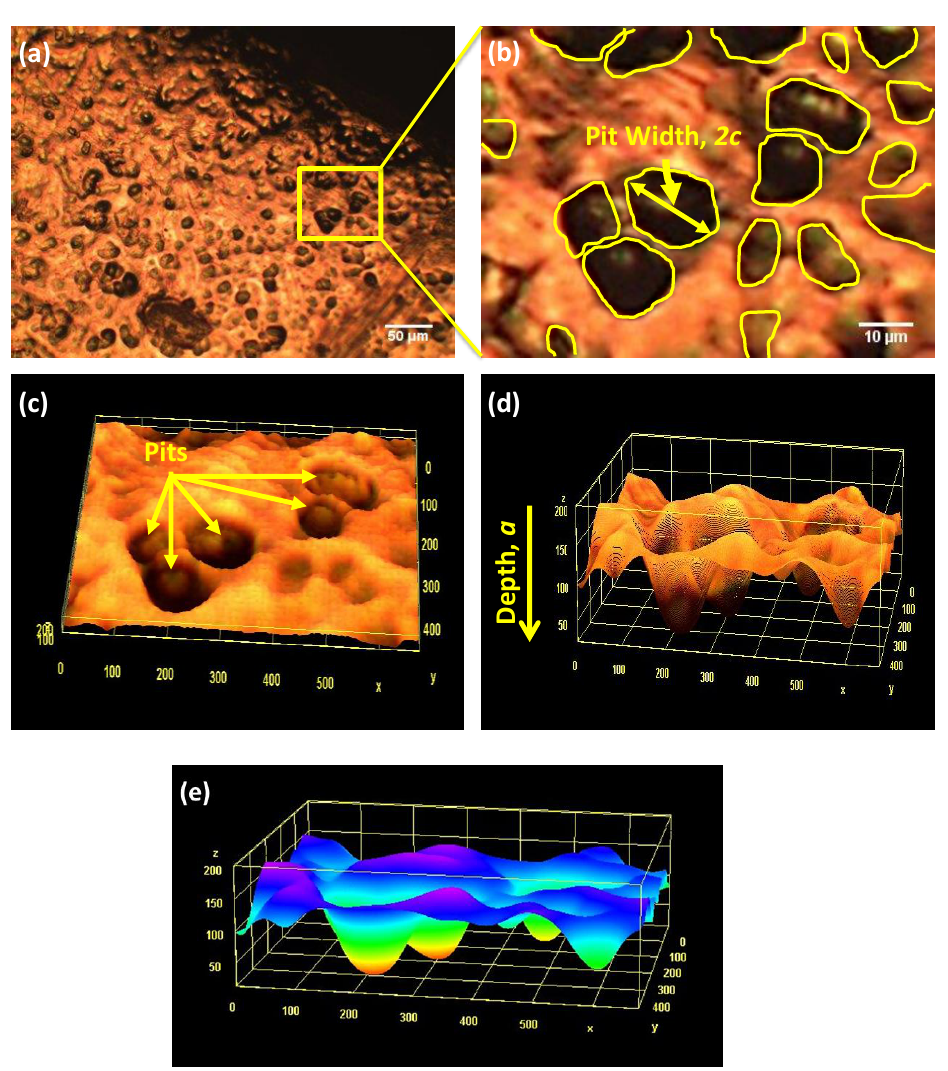
Figure A3. Pitting observed on the PHILOS plate. ( a ) High magnification image indicates pitting. ( b ) Higher magnification image showing pit boundaries. ( c ) 3D morphology; ( d ) 3D surface plot showing the depth of the pit. ( e ) The spectrum of the 3D surface plot (red represents the deeper part and blue represents the surface). The scale represents the number of pixels (10 pixels = 1 µm).